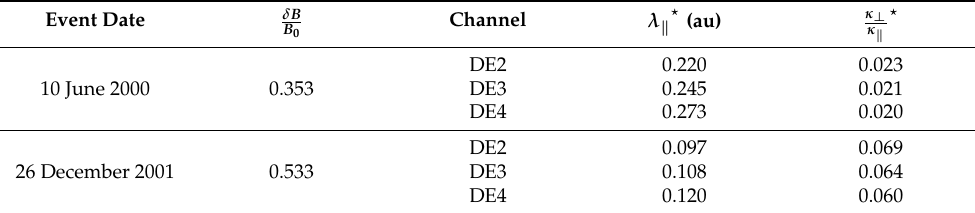
Table 4. Diffusion coefficients calculated from the models with the best fit parameter of the turbulence level δ B B 0